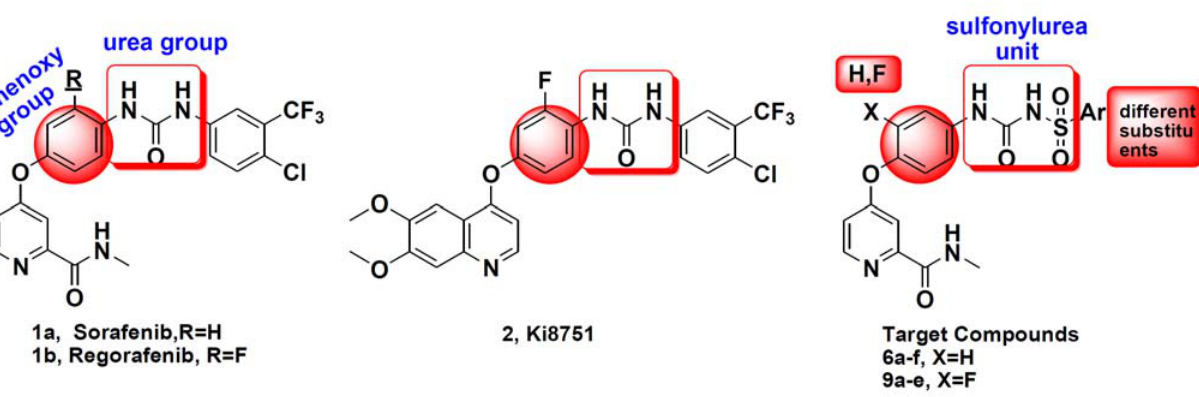
Figure 1. Structures of small-molecule vascular endothelial growth factor